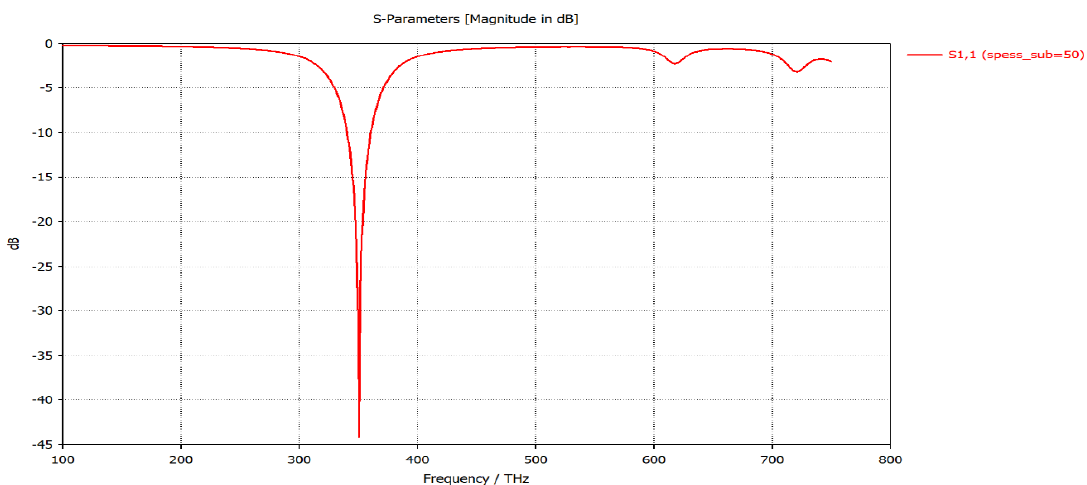
Figure 11. S-parameter magnitude (dB) vs. Frequency.